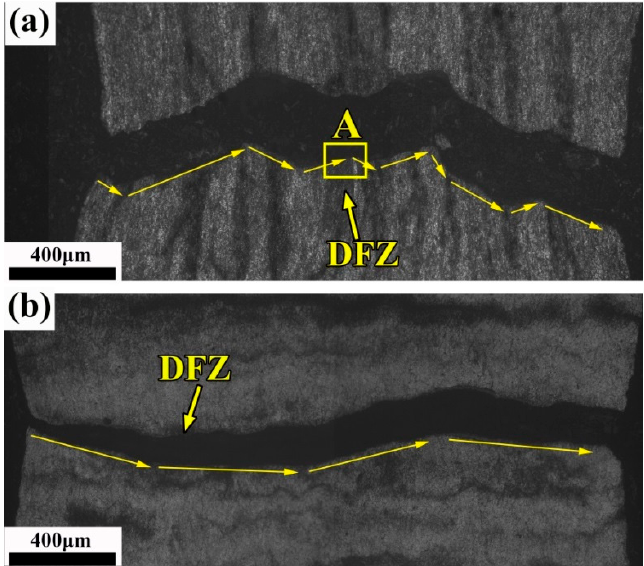
Figure 10. The OM images of the fractured samples in the two directions after the tensile tests: ( a ) 0° sample; ( b ) 90° sample. Note that the yellow arrow refers to the crack propagation direction.